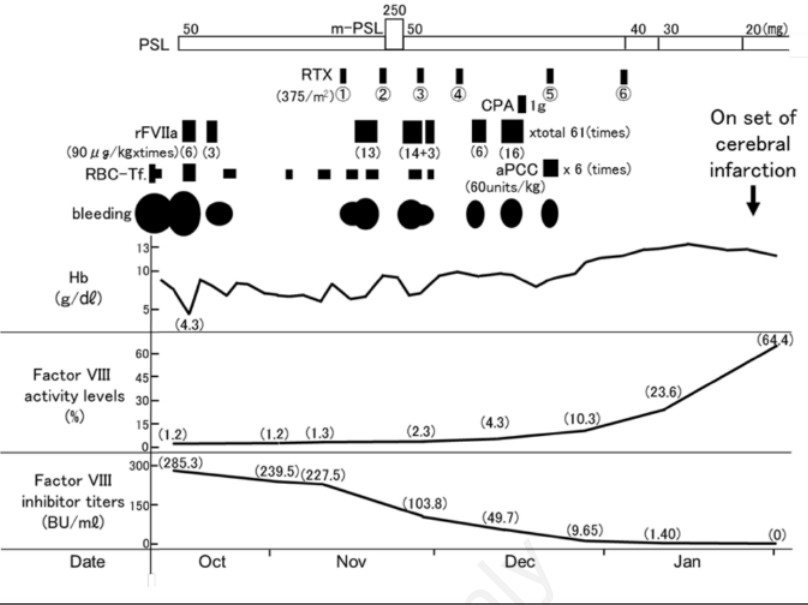
Figure 1. Clinical course of the patient. Hb, hemoglobin; RBC-Tf., red blood cell trans- fusion; rFVIIa, recombinant human coagulation factor VIIa; aPCC, activated prothrom- bin complex concentrate; PSL, prednisolone; m-PSL, methylprednisolone; RTX, ritux- imab; CPA, cyclophosphamide.